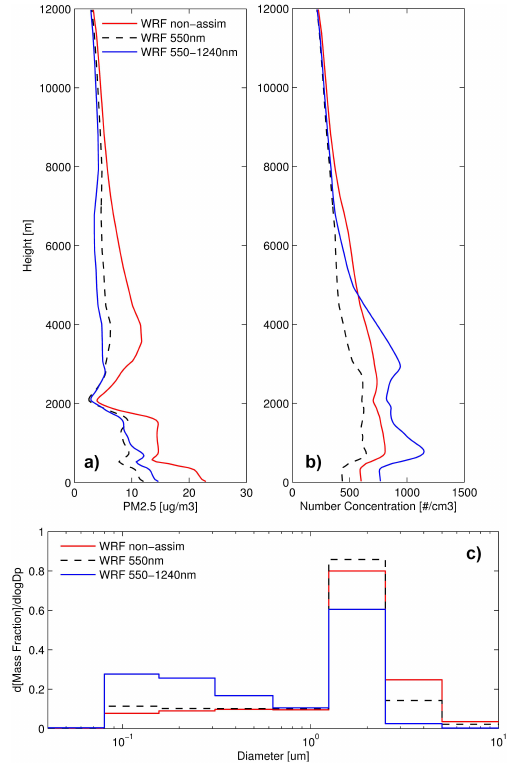
Fig. 12. On the top, vertical profiles for PM 2 . 5 (a) and aerosol num- ber concentration over 80nm diameter (b) ; and on the bottom, mass fraction size distribution at 4km altitude (c) , for forecasts on 6 May 2010 at 21:00UTC. The forecasts are the non-assimilated and the two assimilated using the 550nm AOD only (control) and multiple wavelength AOD retrievals. Data assimilation was performed 3h before (18Z the same day). For 8 bin MOSAIC, dlogDp is